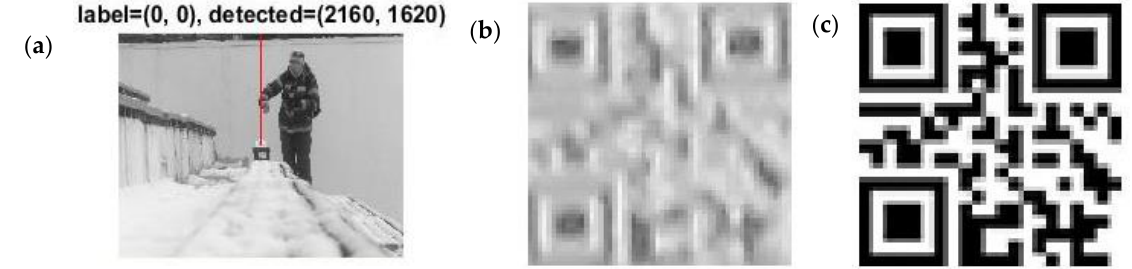
Figure 21. Finding the target center based on the reference and input images: ( a ) image acquisition; ( b ) input image of 100 × 100 pixels; ( c ) reference image.